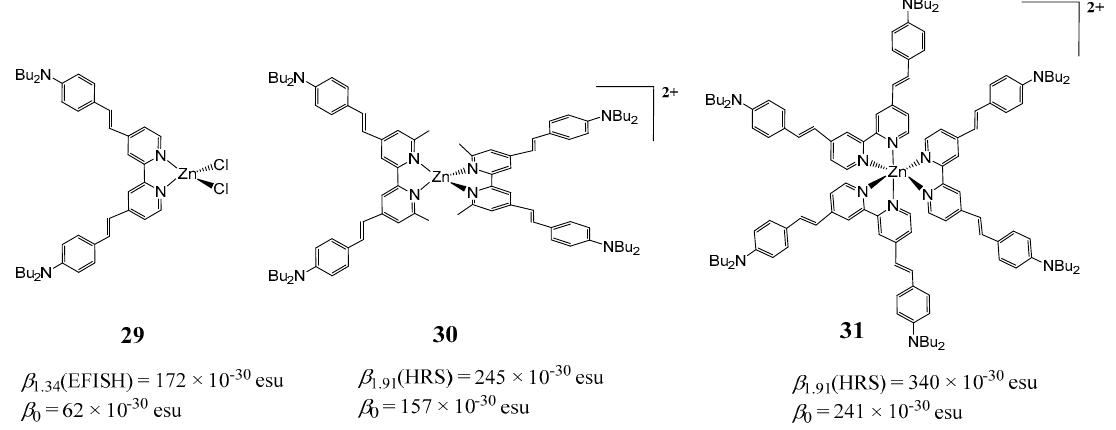
Figure 8. Dipolar and octupolar architectures based on zinc(II) complexes.